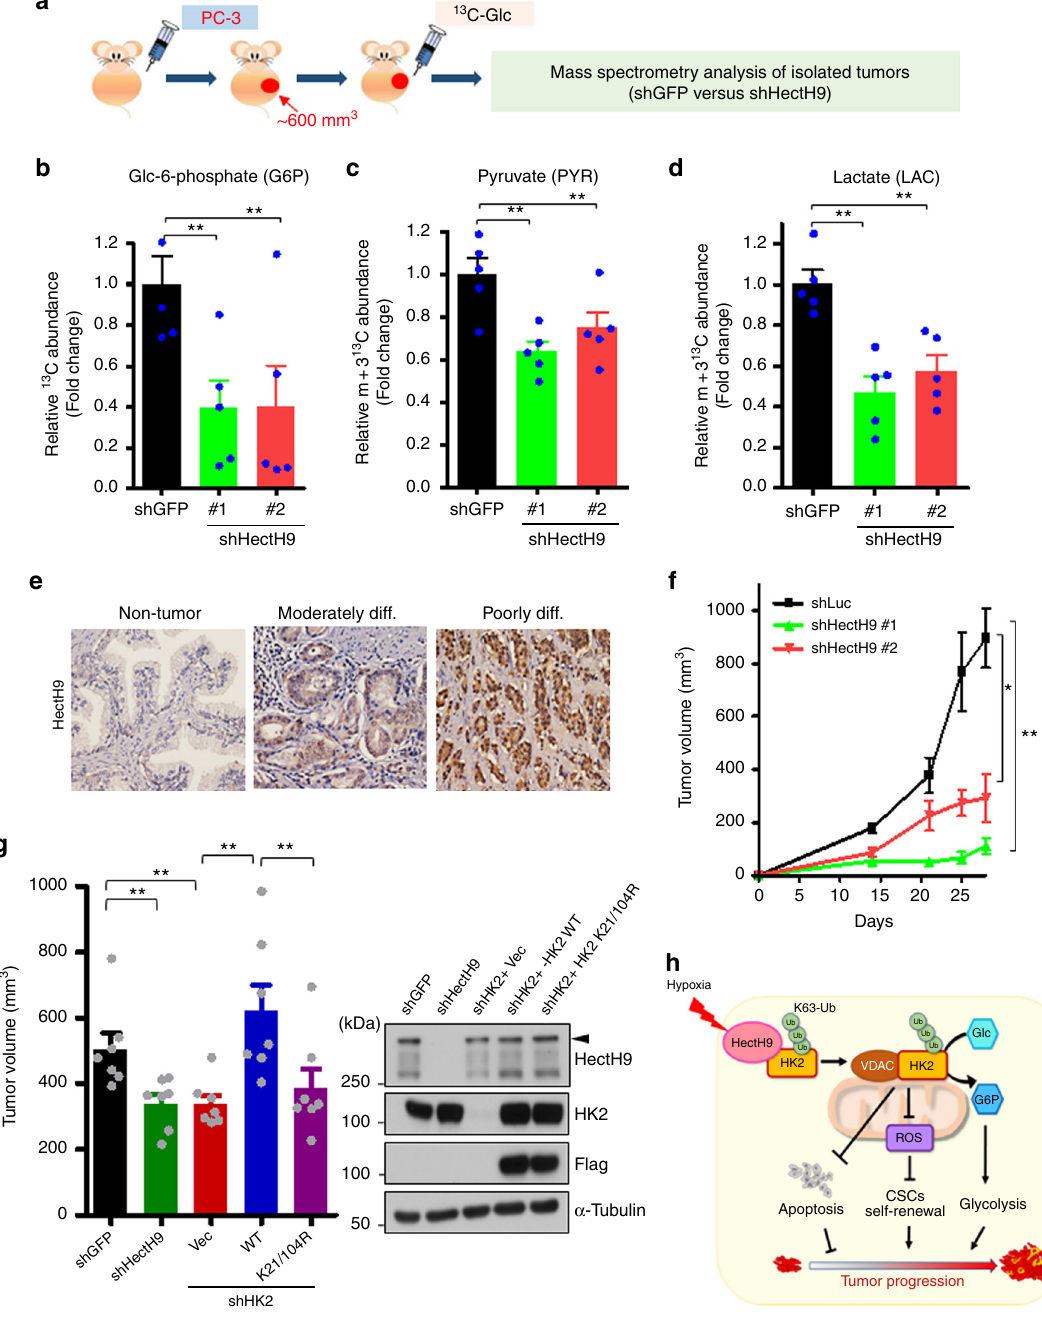
Fig. 7 HectH9 de fi ciency inhibits tumor metabolism and progression. a A schematic illustration depicting the process of metabolite pro fi ling in HectH9- pro fi ceint and HectH9-de fi cient PC-3-derived prostate tumors by GC-MS. b – d Relative abundances of 13 C-labeled glucose-6-phosphate ( b ), pyruvate ( c ) and lactate ( d ) were quanti fi ed by GC-MS ( n = 5). e Representative images of consecutive tissue sections for histological analyses of HectH9 expressions in normal tissues and prostate tumors with moderately or poorly differentiation status ( n = 225). f In vivo primary tumor growth derived from PC-3 cells with Luciferase or HectH9 knockdown. Cells were injected subcutaneously into the right fl anks of nude mice and tumorigenesis was monitored ( n = 5 in each group). g In vivo primary tumor growth derived from MDA-MB-231 cells with HectH9 or HK2 depletion, as well as HK2-depleted MDA-MB-231 cells restored with vector alone (pBabe), WT or K21/104R of Flag-HK2. Cells were injected into the mammary fat pads of nude mice and tumorigenesis was monitored. Quantitative results of tumor volumes at day 31 are shown in the left ( n = 7 in each group). IB analysis of HectH9 and HK2 expression in MDA- MB-231 cells with GFP, HectH9 and HK2-depletion, as well as HK2-depleted cells restored with vector alone (pBabe), WT or K21/104 R of Flag-HK2 is shown in the right. h The working model depicts that hypoxia-induced HectH9, by promoting K63-linked ubiquitation of HK2, contributes to tumor progression via concomitant glycolysis elevation and apoptosis inhibition in cancer cells, as well as enhanced self-renewal of CSCs mediated by ROS blockade in tumors. Results in b – d, f and g are presented as mean value ± SEM; * p < 0.05, ** p < 0.01, by Student ’ s t